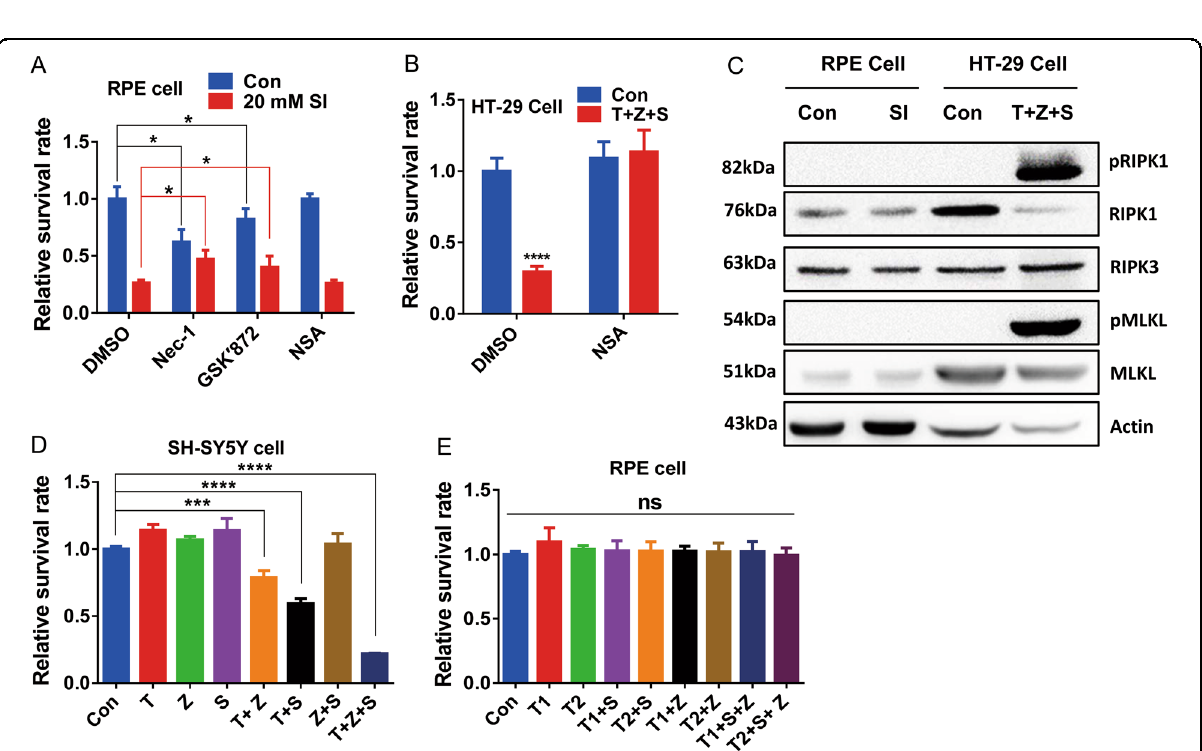
Fig. 2 Necroptosis is not the main pathway related to the death of ARPE-19 cells induced by SI. A Cell viabilities of ARPE-19 cells treated with 200 μ M Nec-1, 2 μ M NSA or 10 μ M GSK ′ 872 for 24 h before 20 mM NaIO 3 treatment for 24 h ( n = 4). B HT-29 cells with or without necrosulfonamide (NSA) pretreatment was treated with the indicated necrosis-inducing agents for 16 h. T + Z + S: TNF- α (200ng/ml), Z-VAD (20 μ M), and SM-164 (10 μ M) ( n = 4). C Phospho-RIPK1 (S166), total RIPK1, total RIPK3, Phospho-MLKL (S358), and total MLKL were detected in ARPE-19 or HT-29 cells by western blotting. SI: 10 mM NaIO 3 treatment for 24 h. T + Z + S: TNF- α (100ng/ml), Z-VAD (20 μ M), and SM-164 (10 μ M) treatment for 3 h. D Cell viabilities of SH-SY5Y cells treated with the indicated necrosis-inducer agent(s) for 3 h. T: 100 ng/ml TNF- α ; S: 10 μ M SM-164; Z: 20 μ M Z-VAD ( n = 4). E Cell viabilities of ARPE-19 cells treated with the indicated necrosis-inducer agent(s) for 48 h. T1: 50 ng/ml TNF- α ; T2: 100 ng/ml TNF- α ; S: 10 μ M SM- 164; Z: 20 μ M Z-VAD ( n =